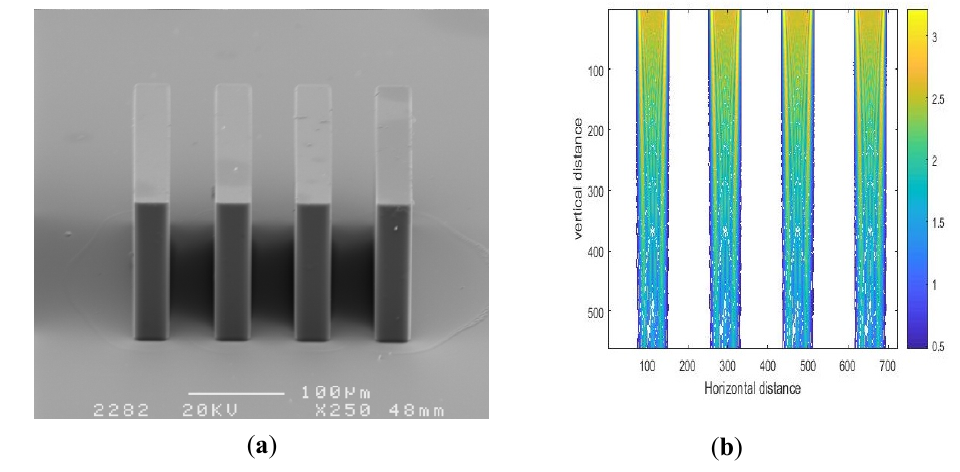
/ spacewidth of 30 / 50 µ m. ◦ and